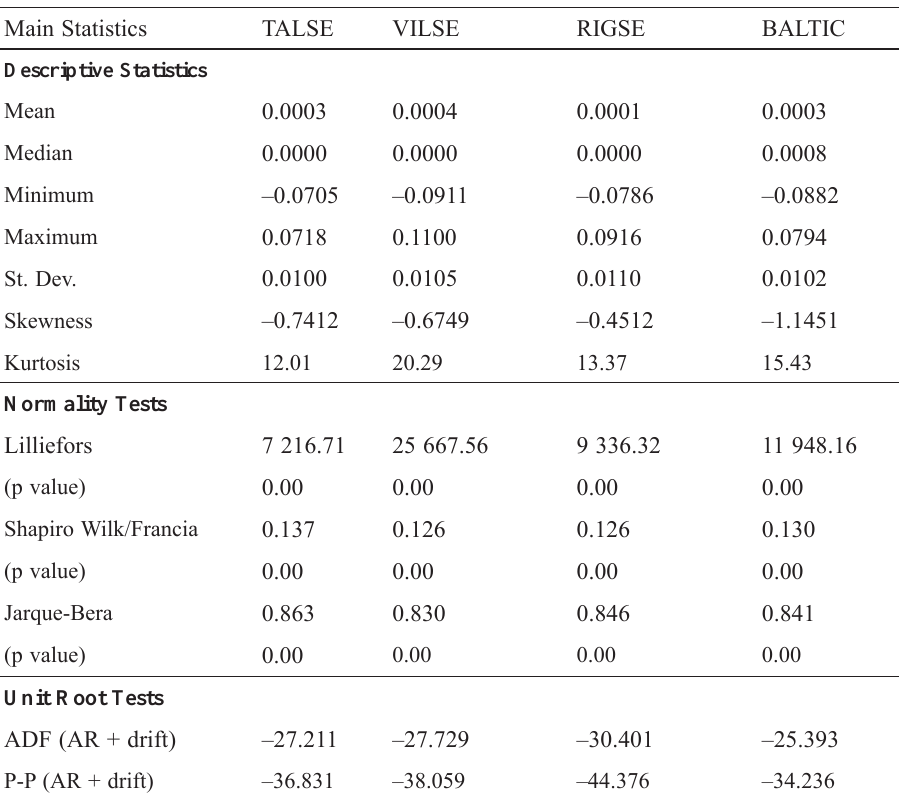
Table 1. Descriptive Statistics for TALSE, VILSE, RIGSE and BALTIC Benchmark